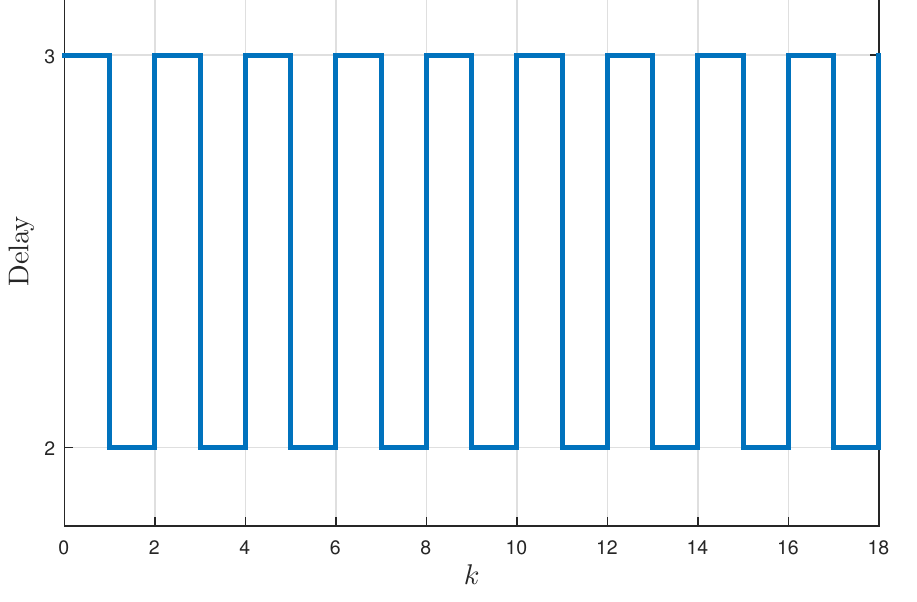
Figure 4. Variation of d ( k ) .